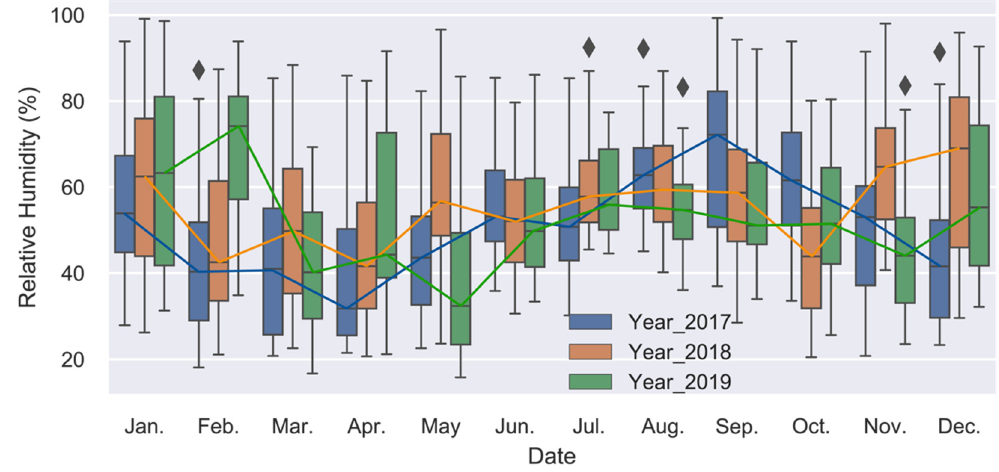
Figure A5. The distribution of minimum daily relative humidity for three years.